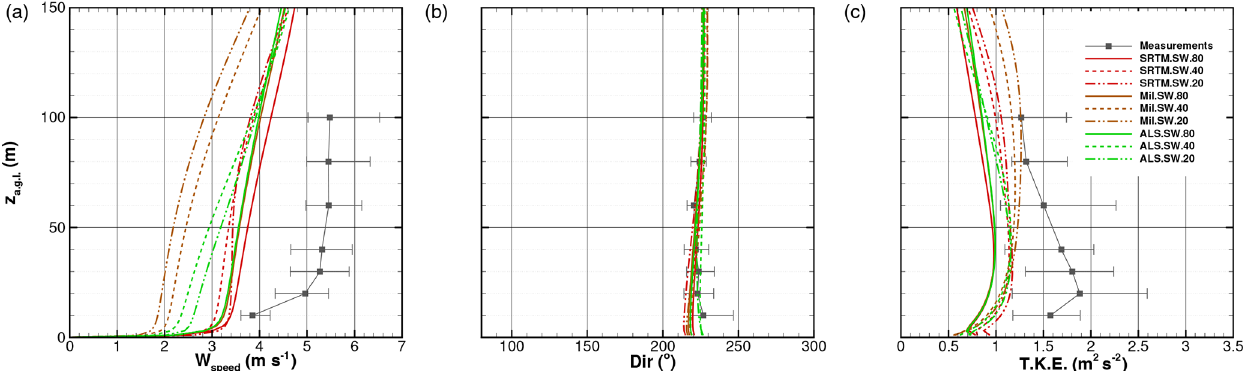
Figure 16. Simulation results and experimental data in tower 29/tse13 for SW winds: (a) wind speed, (b) wind direction, (c) turbulent kinetic